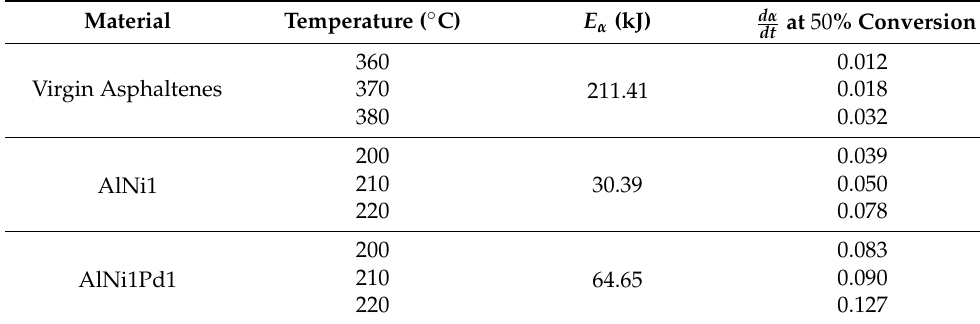
Table 3. The estimated effective activation energy ( E α ) and kinetic rate for isothermal catalytic steam gasification of asphaltenes in the absence and presence of AlNi1 and AlNi1Pd1